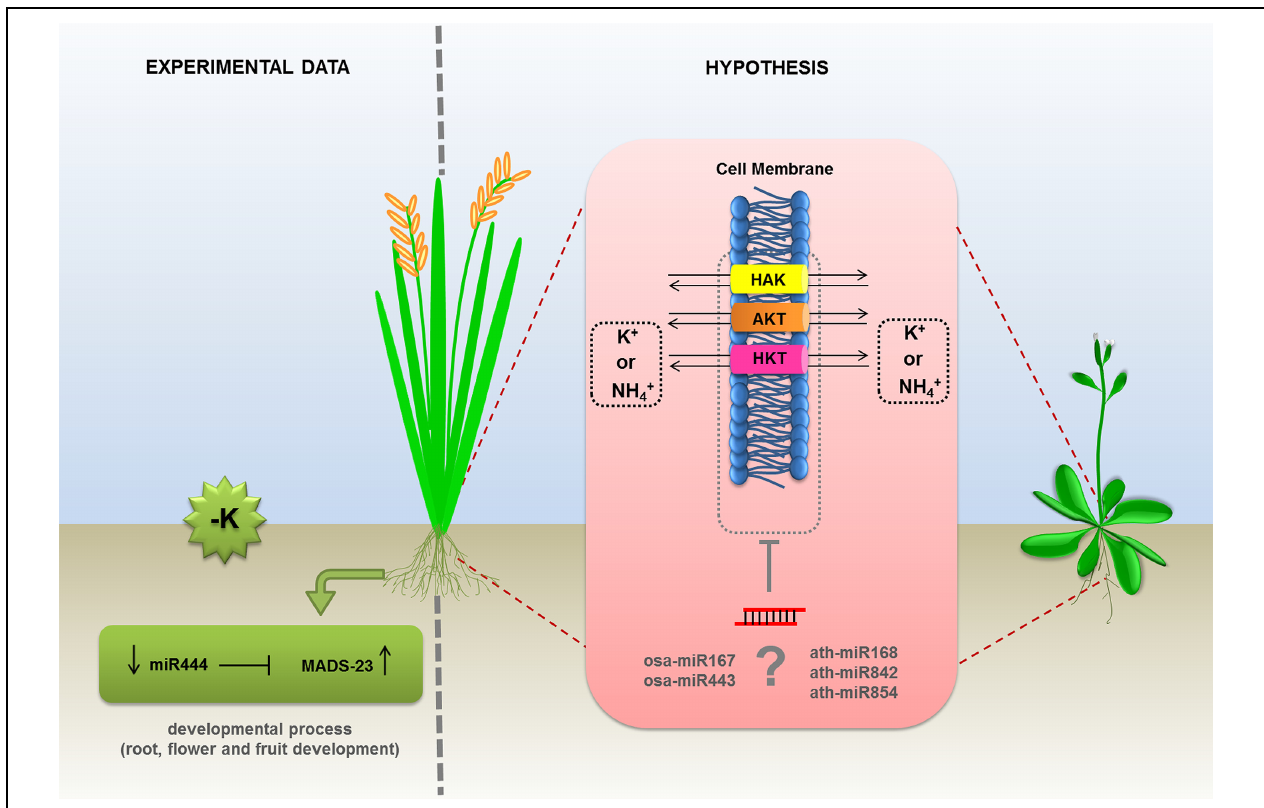
FIGURE 3 | Proposed models of regulation of potassium transportation by miRNAs in plants. The expression levels of MADS-23 transcription factor, involved in potassium uptake, was experimentally demonstrated as regulated by miR444 in monocots. The transcripts of AKT (ankyrin potassium transporter), HAK, and HKT1 (high affinity